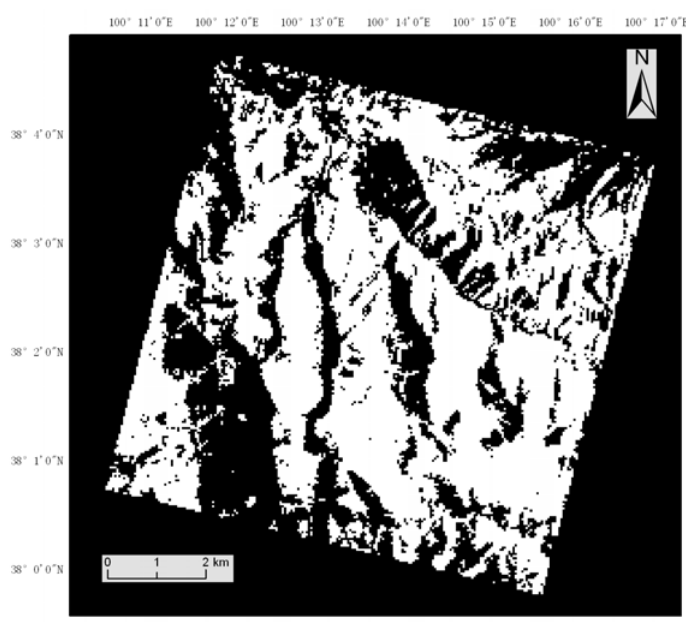
Figure 9. Snow-covered areas of the Binggou watershed.